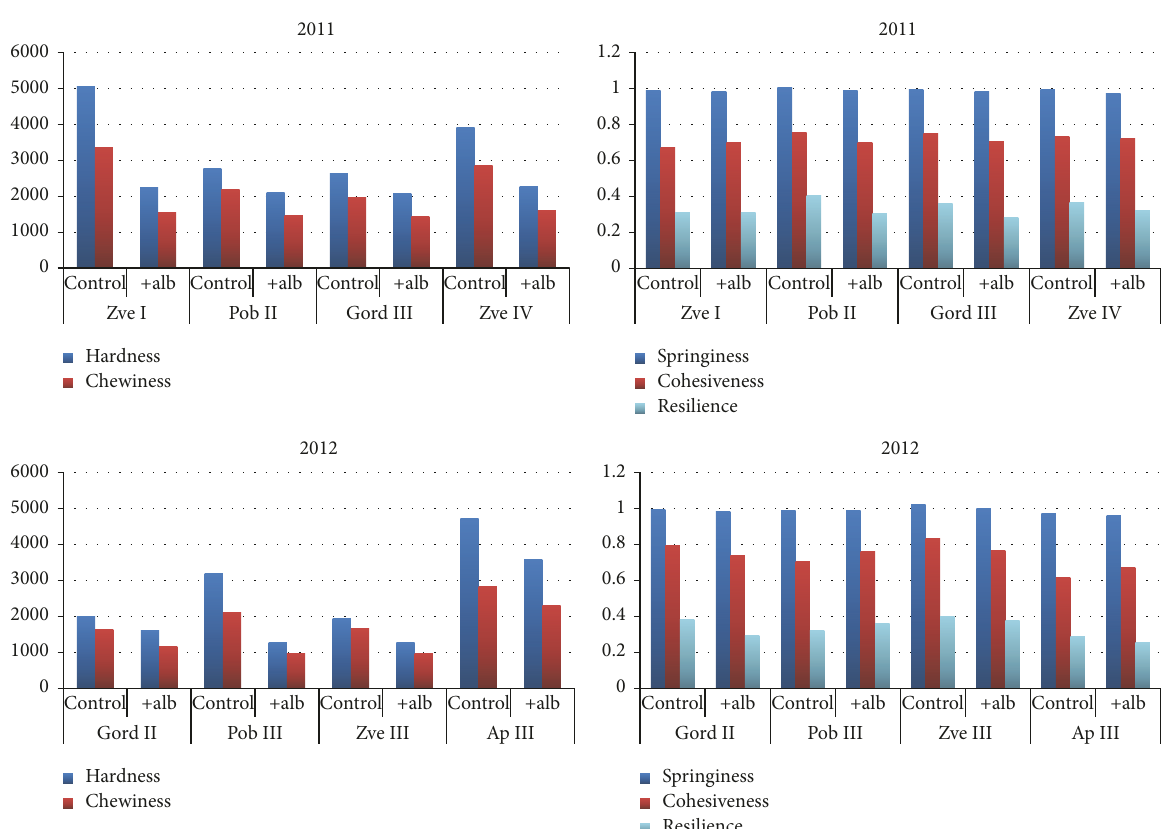
Figure 6: Results of texture measurements obtained 24 h after baking for bread enriched with albumin and control bread.